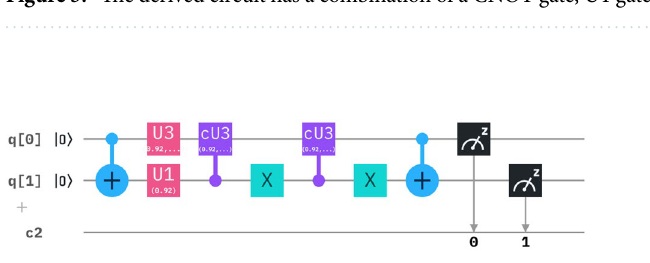
Figure 4. The equivalent circuit describes the Hamiltonian operator 7 in a N = 2